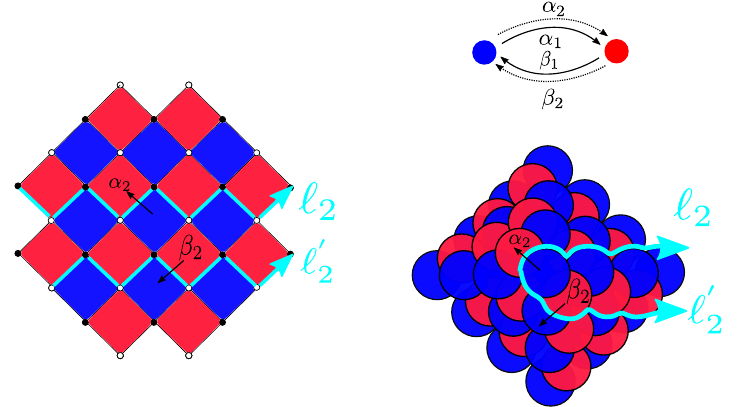
. The ‘ 0 here is the same 2 2 is surrounded by divisors 2